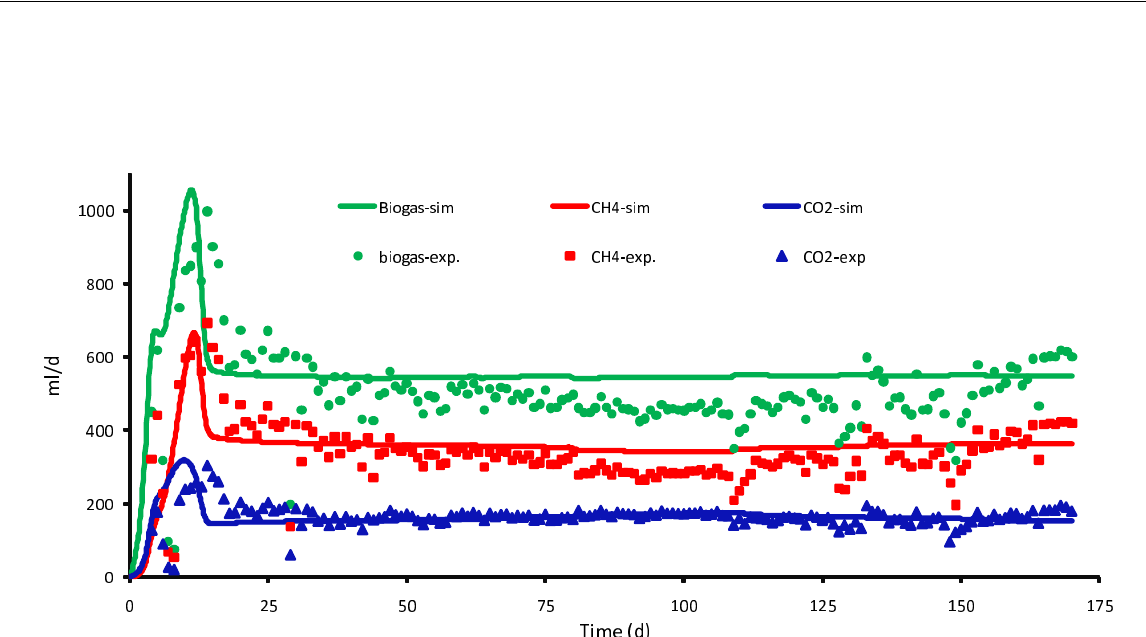
Figure 1: Experimental and simulated time variations of CO 2 , CH 4 and total biogas of the (semi) continuous digester.